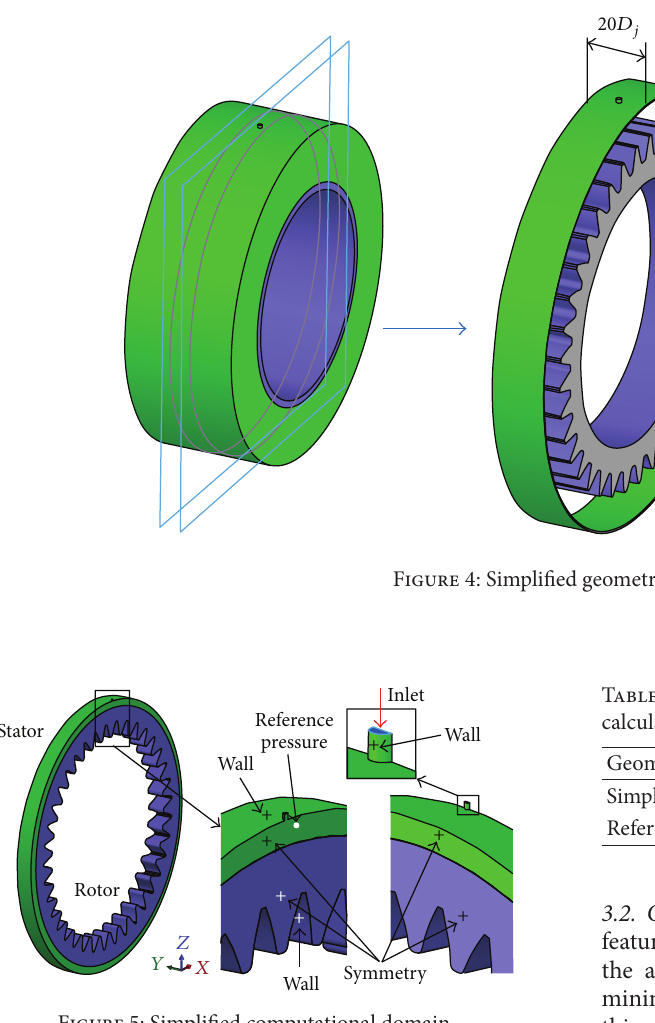
Figure 5: Simplified computational domain.